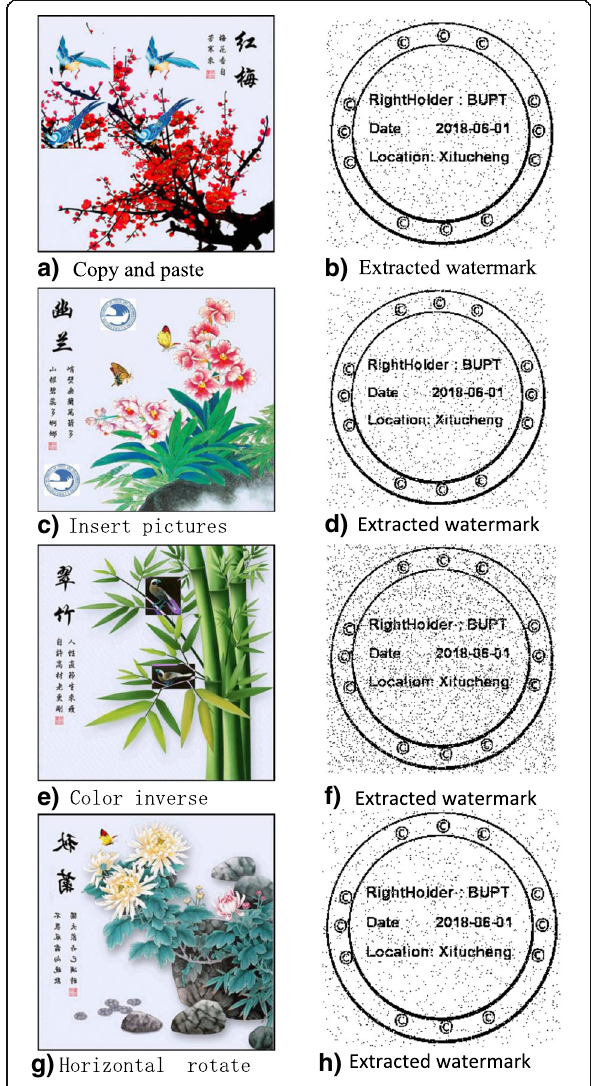
Fig. 7 a – h Experiment images attacking and